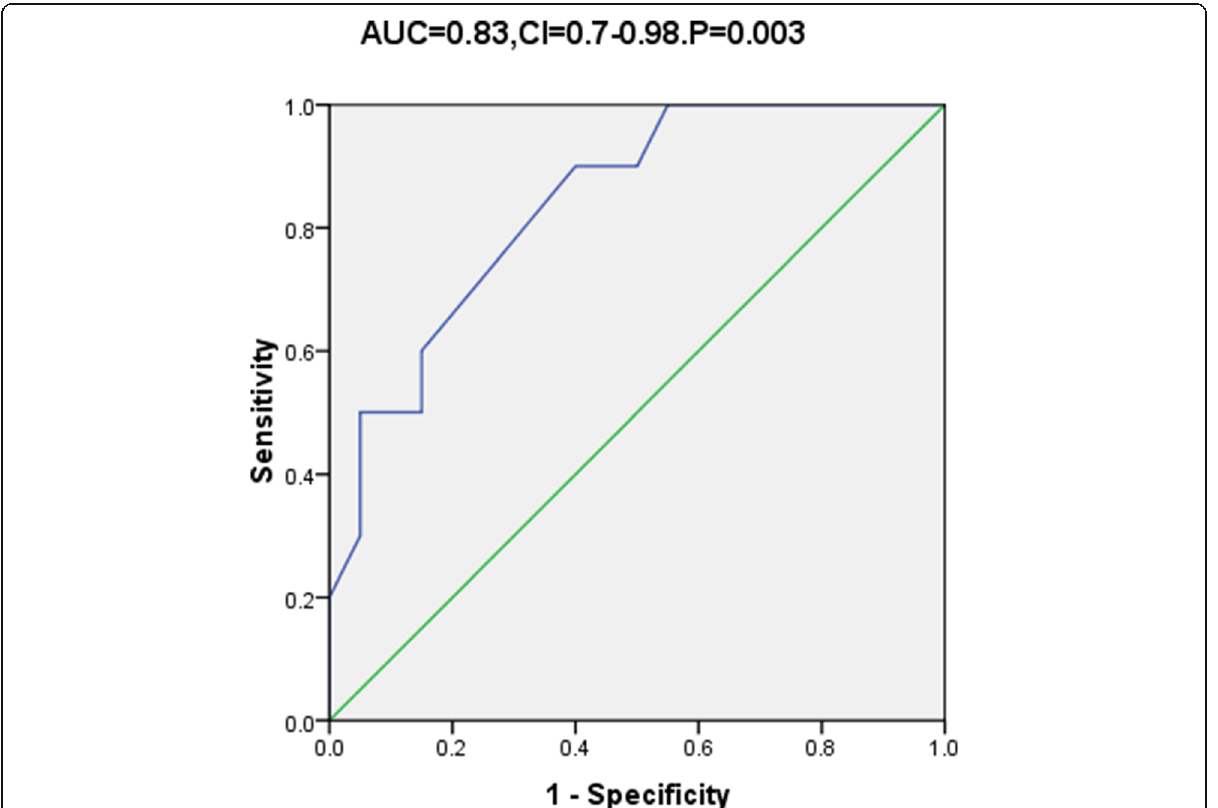
Fig. 4 ROC curve of pre-treatment of B-natriuretic peptide (BNP) serum levels. ROC analysis of the initial BNP serum level that revealed an AUC of 0.83 with CI = 0.7 – 0.98 and p =